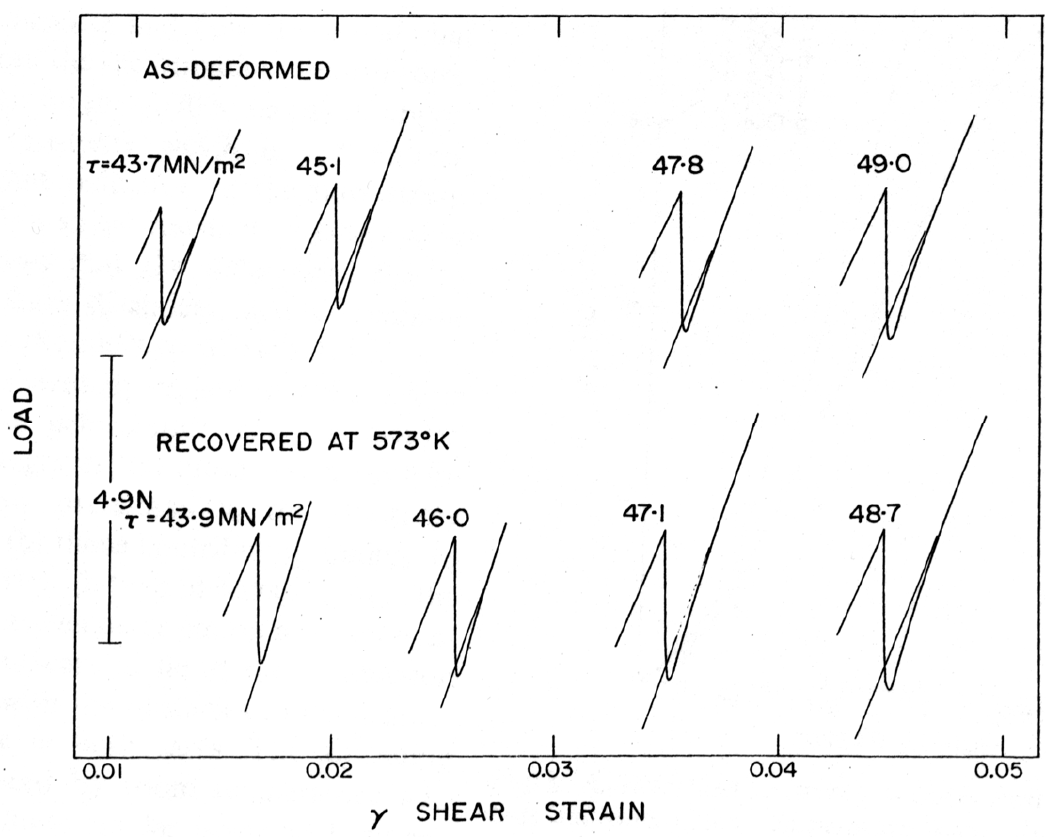
Figure 2. Traces of load drops which accompany a down-strain rate change at 298 K in Cu crystal. The tangent slope line is back extrapolated to show the existence of transients. After ref. [21].